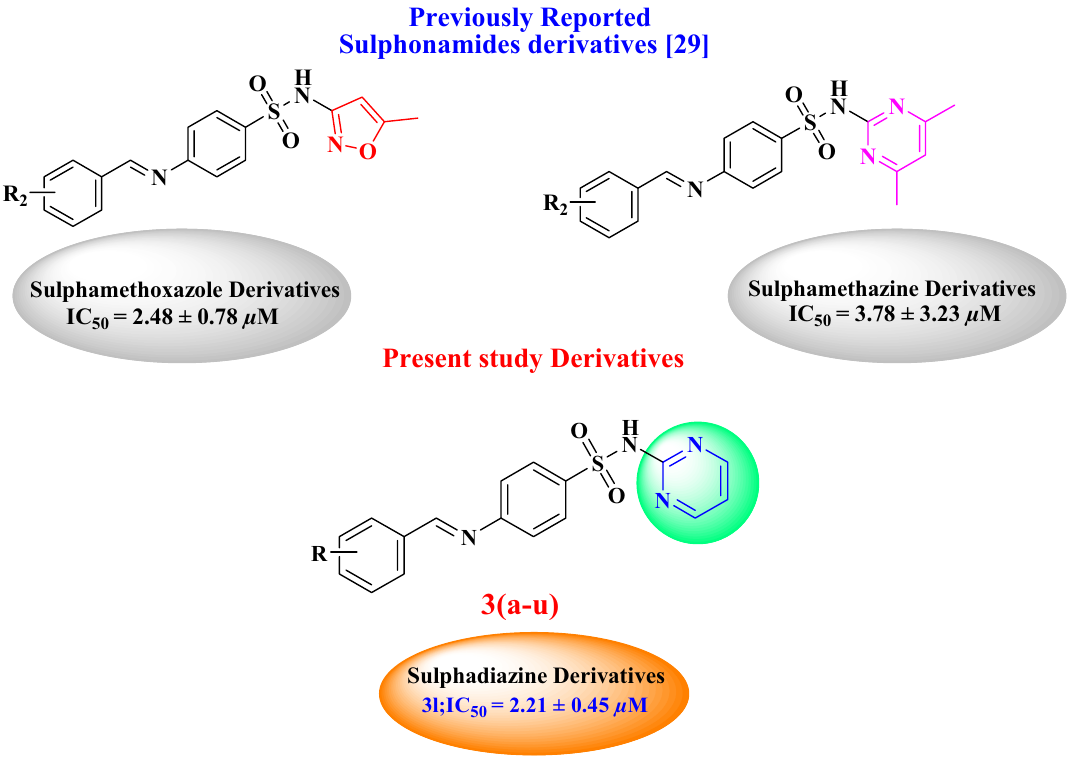
Figure 1. Rationale of present study with reported